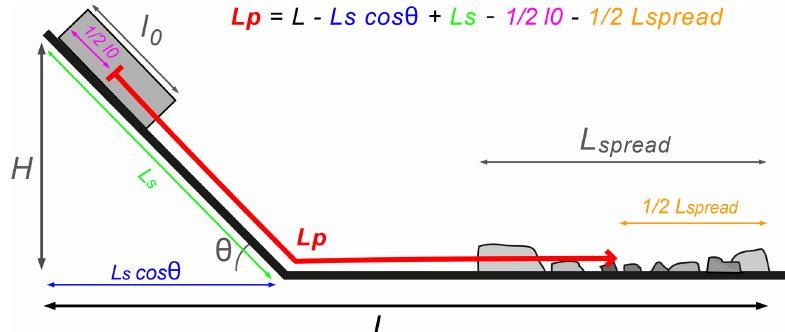
Figure A1. Definition of distances used in Eq. (3). L p is the length of the travel path.